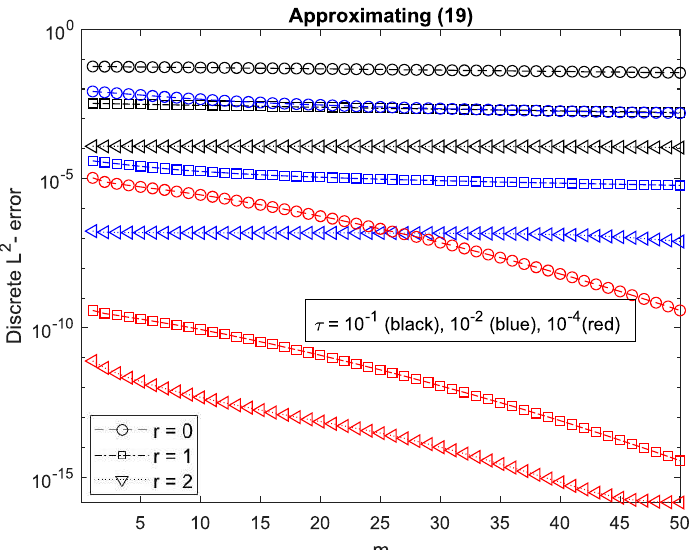
Figure 5. Discrete L 2 -error against number of Krylov iterations when approximating (19) for the data in Section 2.1 for different values of τ , r = 0,1,2 and fixed h = 10 − 3